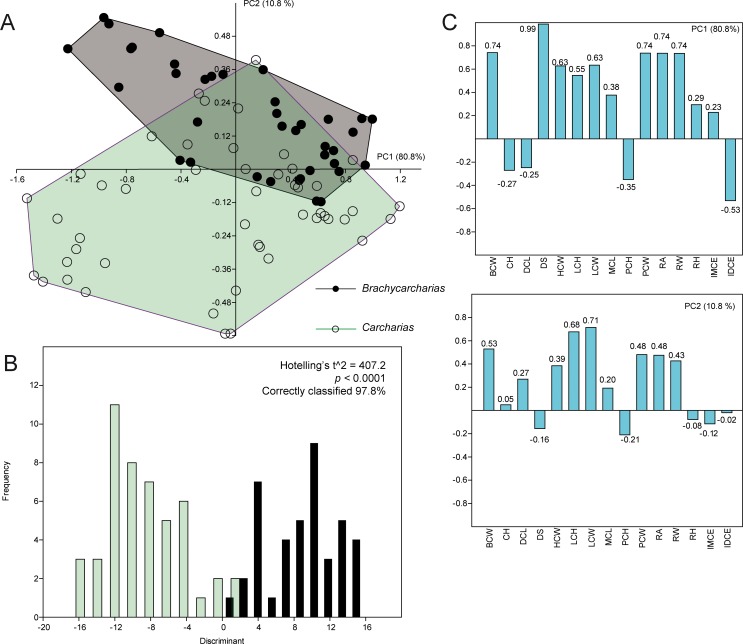
PCA.Results of the PCA performed on the standardized and log-transformed measurements for Brachycarcharias and Carcharias. (A) Morphospace plotted on PC1 and PC2; (B) Discriminant analysis results; (C) Loading values showing the variables associated with the two PC axes.